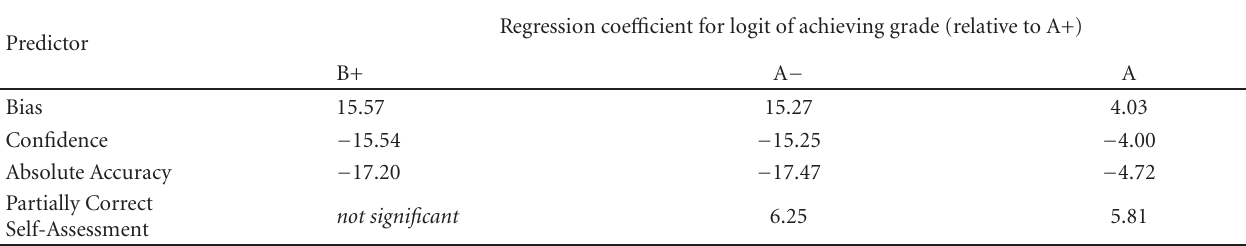
Table 3: Results of multinomial regression procedure using performance assessment (grade) as predicted variable with monitoring and task understanding measures as predictors, as well as learner and session as fixed e ff ects ( n of essays =